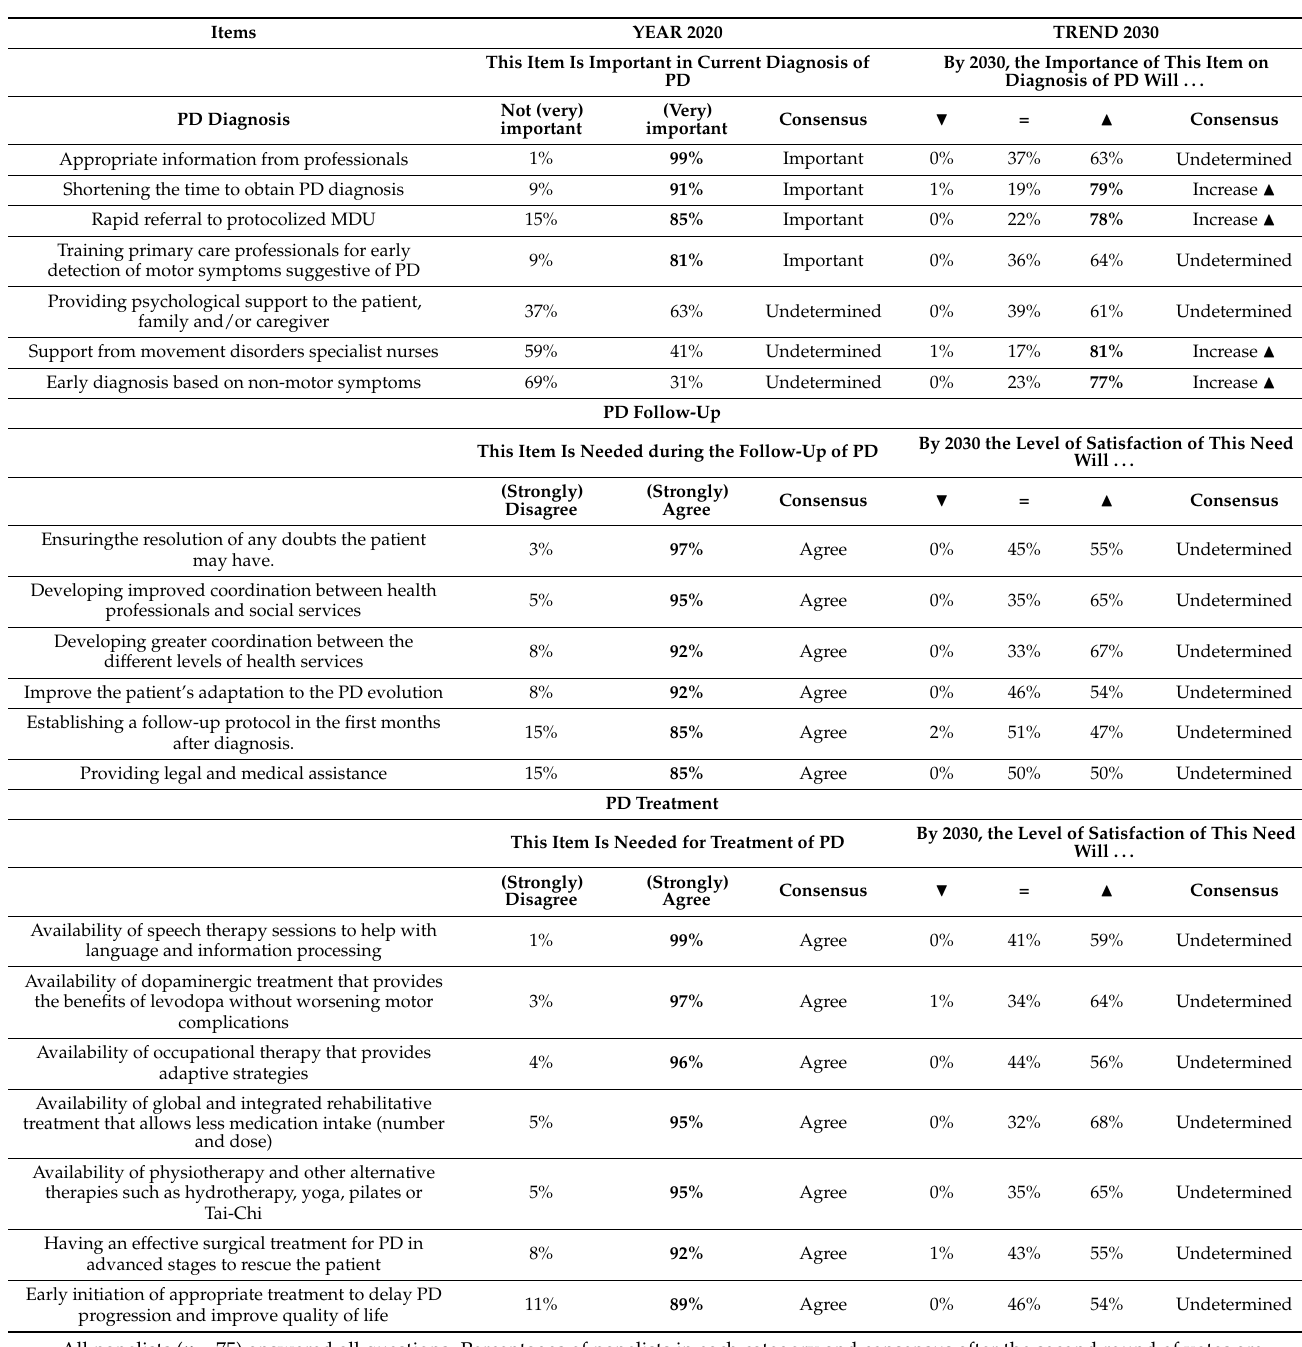
Table 6. Needs of PD management: present and